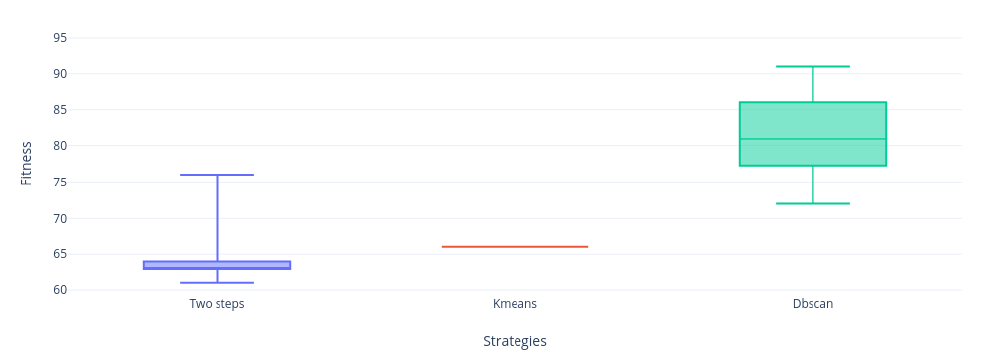
Figure 13. Instance c.5 distribution.